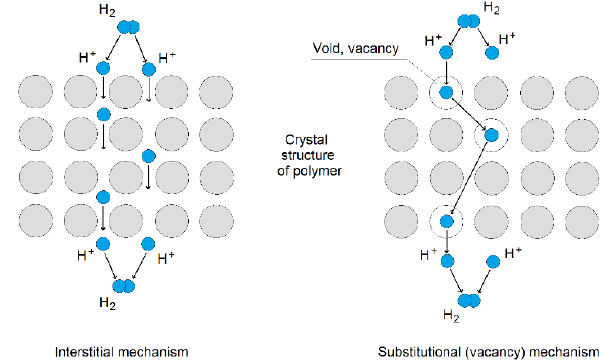
Figure 2. Tortuosity effect in hydrogen diffusion process.